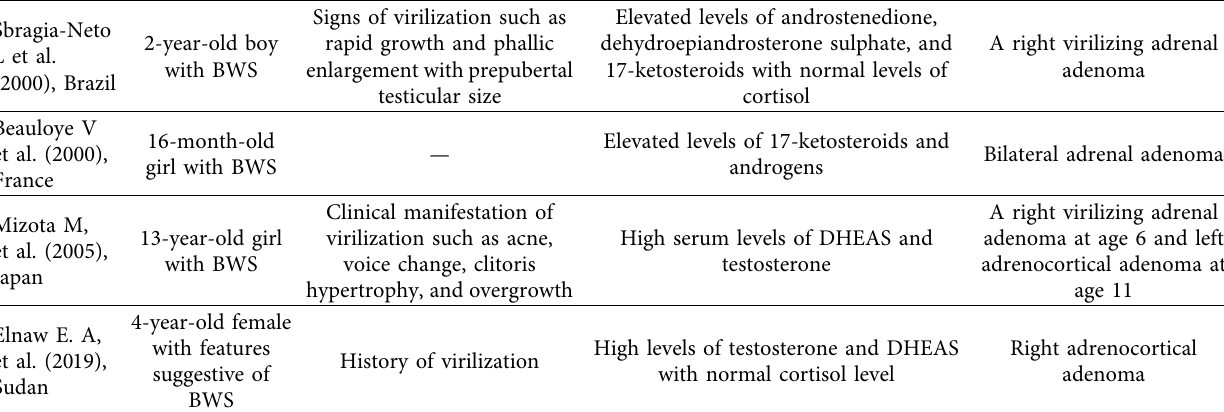
Table 5: Cases of adrenocortical adenoma in BWS in the literature